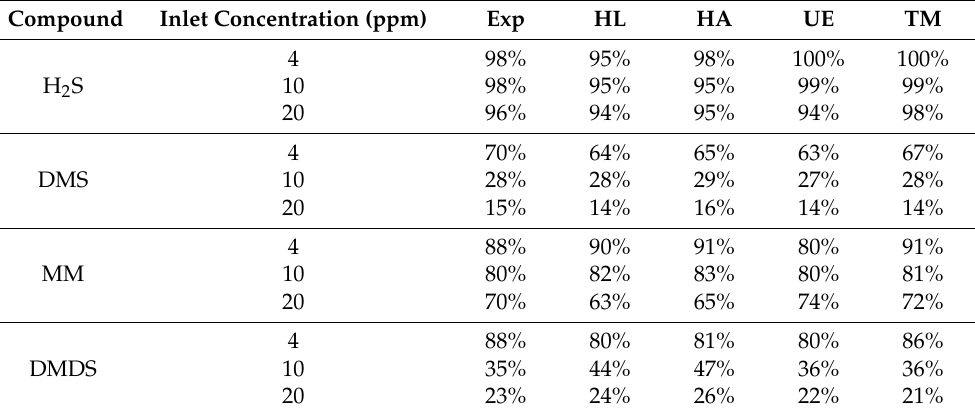
Table 3. Removal capacities determined by experimental data (Exp), Henry’s Law (HL), Henry’s law adjusted (HA), Extended UNIQUAC (EU), Two-parameters model